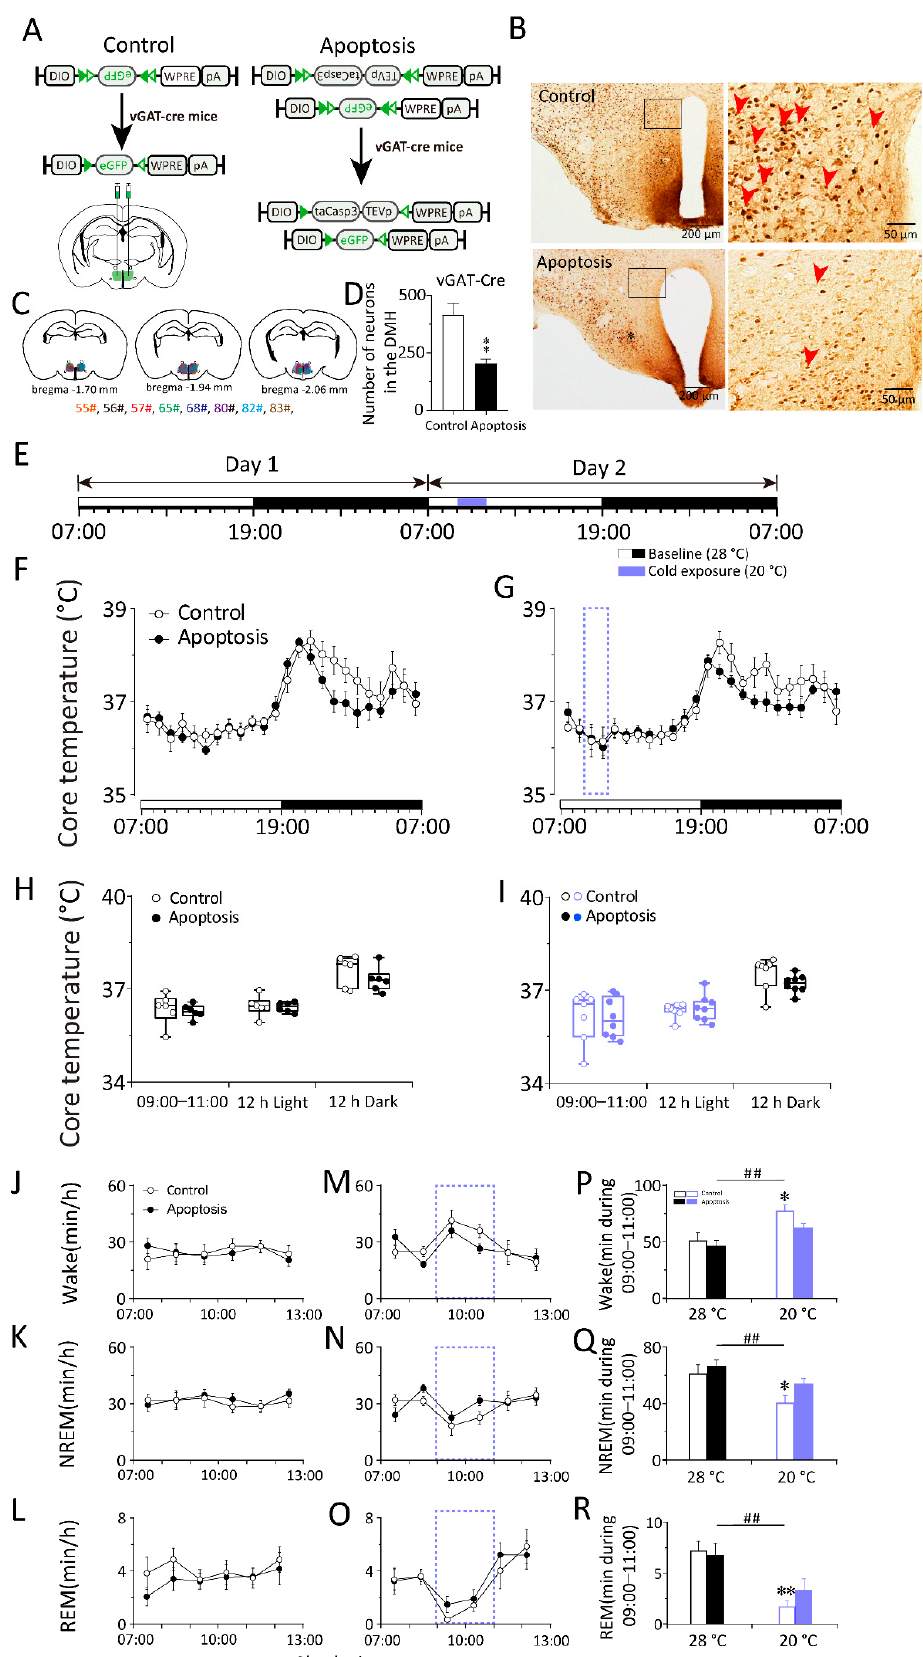
Figure 5. Cold exposure did not influence the core body temperature of the control or DMH GABAer- gic apoptosis mice, whereas it alleviated the wakefulness elicited by cold exposure in vGAT-Cre